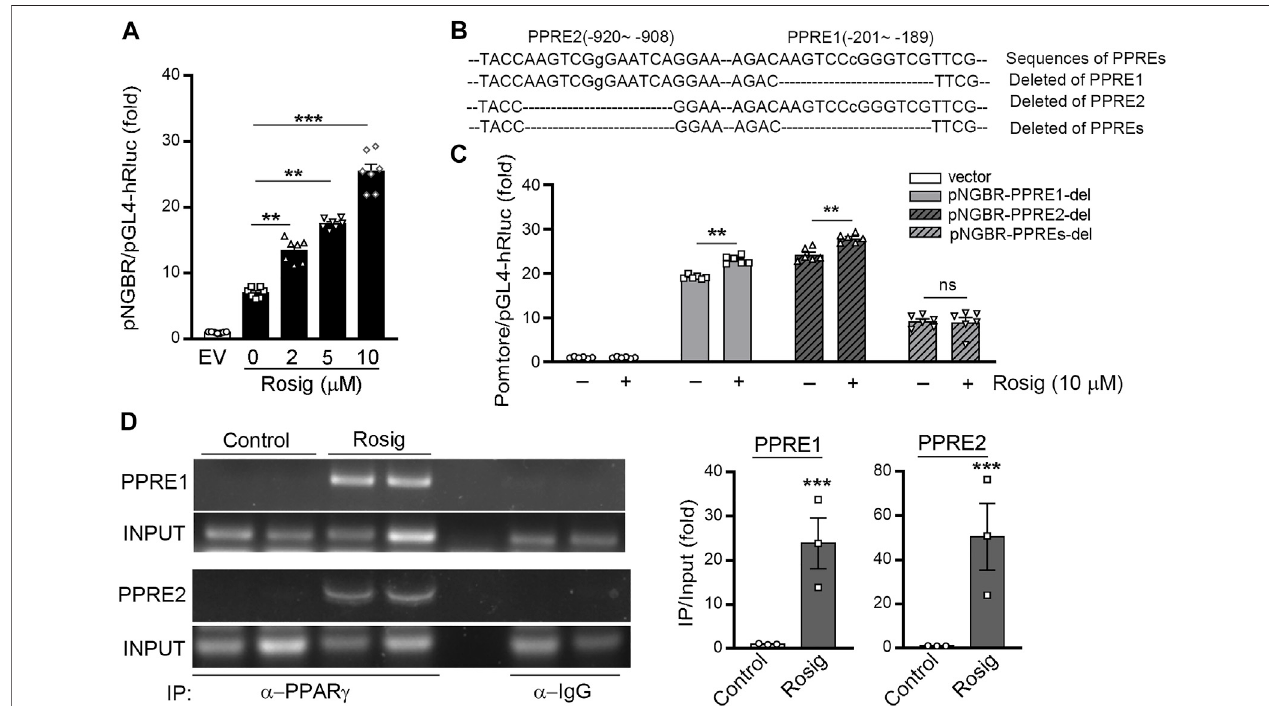
FIGURE 3 | PPAR γ activates NGBR transcription. (A) 293T cells were transfected with pNGBR (from − 983 to +167) and Renila luciferase vector (20:1) overnight, thentreatedwithrosiglitazoneattheindicatedconcentrations.* p < 0.05( n (cid:1) 7); (B) thesequenceofNGBRpromoterwiththetwopotentialPPREs(PPRE1,from − 201to − 189; PPRE2, from − 920 to − 908), individual or both deletion; (C) 293T cells were transfected with pGL4 vector, pNGBR-PPRE1-del, pNGBR-PPRE2-del or pNGBR- PPREs-del overnight. Then, the cells received the indicated treatment (rosiglitazone, 10 μ M) for 24 h in serum-free medium. Cell lysates were used to determine fi re fl yandRenillaluciferasesactivity.* p < 0.05;** p < 0.01;*** p < 0.001;ns,notsigni fi cant( n (cid:1) 6); (D) HUVECsweretreatedwithorwithoutrosiglitazone(10 μ M)for24 h. Immunoprecipitation (IP) assay was performed with anti-PPAR γ antibody or non-speci fi c IgG overnight. The enrichment of PPAR γ protein in the PPRE in NGBR promoter was determined by PCR. * p < 0.05; ** p < 0.01; *** p < 0.001 ( n (cid:1) 3). Values were expressed as means ±